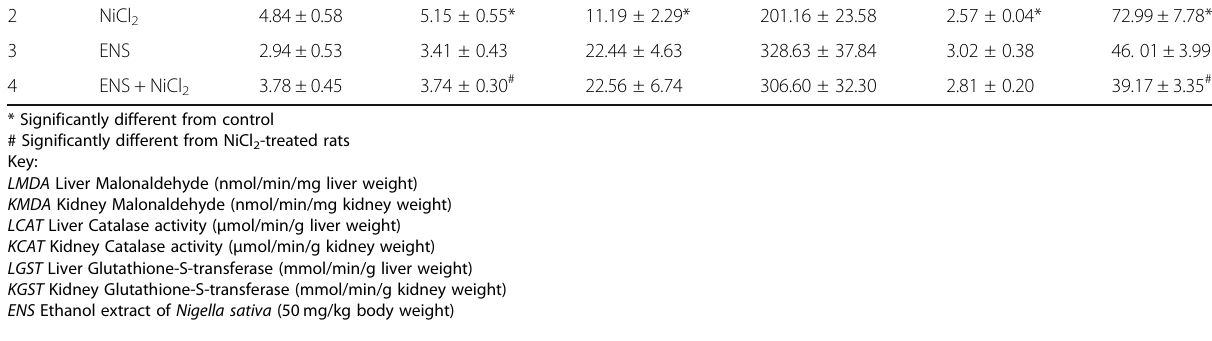
Table 4 Lipid peroxidation and antioxidant enzymes activities in the liver and kidney of test and control animals SN Treatment LMDA KMDA LCAT